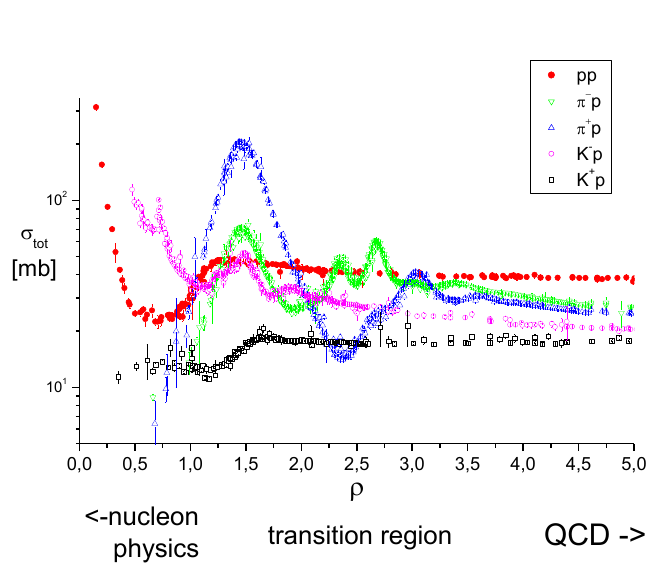
Figure 3. Total cross section of particle production as a function of ρ ik .